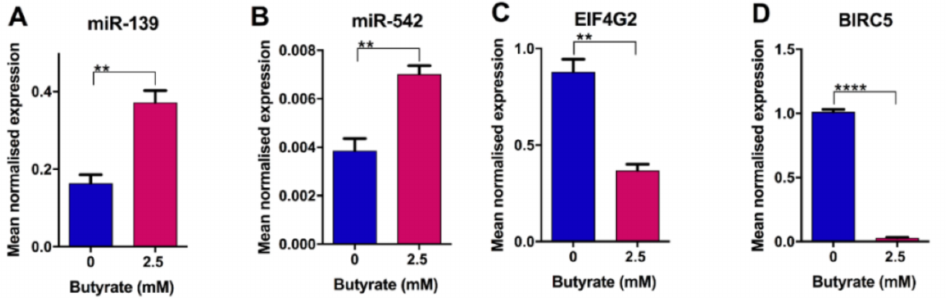
Figure 6. Real-time RT–PCR analysis of networking miRNAs and predicted target gene expression validation in HCT116 cells treated with 2.5 mM butyrate for 24 h. Expression levels of miRNAs and predicted target genes identified by network analysis ( A ) miR-139, ( B ) miR-542, ( C ) EIF4G2 , ( D ) BIRC5 in HCT116 cells treated with 0 mM or 2.5 mM butyrate for 24 h. The mean miRNA or mRNA levels ± SEM of ( n = 3) is represented, and their expression is normalized to RNU6B endogenous control (miRNAs only) or the geometric mean of three reference genes, ACTB , B2M and GAPDH (mRNAs only). Significant values are indicated by ** p < 0.01, **** p < 0.0001. NC = negative control